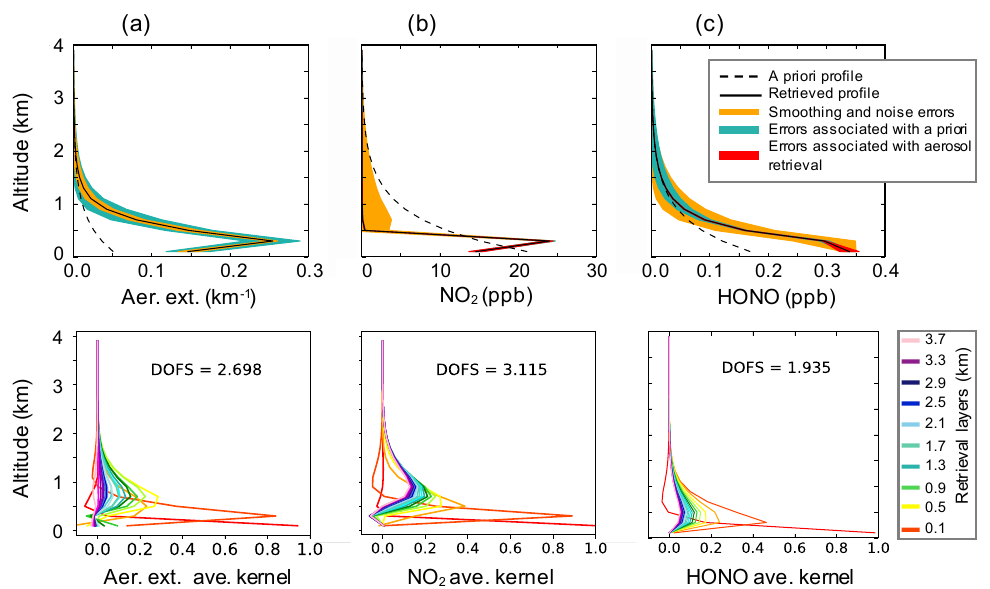
Figure 4. Example profile retrieval results from 13:00LT on 7 March 2017 at Broadmeadows, for (a) aerosol extinction (aer. ext.), (b) NO 2 and (c) HONO. The top row shows the retrieved profiles, plotted with their associated a priori profile, smoothing and noise errors, and the errors associated with uncertainty in the a priori profile as calculated during the retrieval sensitivity tests. The trace gas profiles also include the error associated with total uncertainty in aerosol forward model parameters and uncertainty in the aerosol retrieval. The bottom row presents the averaging kernels and degrees of freedom for signal associated with the profile retrieval. The averaging kernels’ legend represents the centre wavelength of every second retrieval grid layer, for